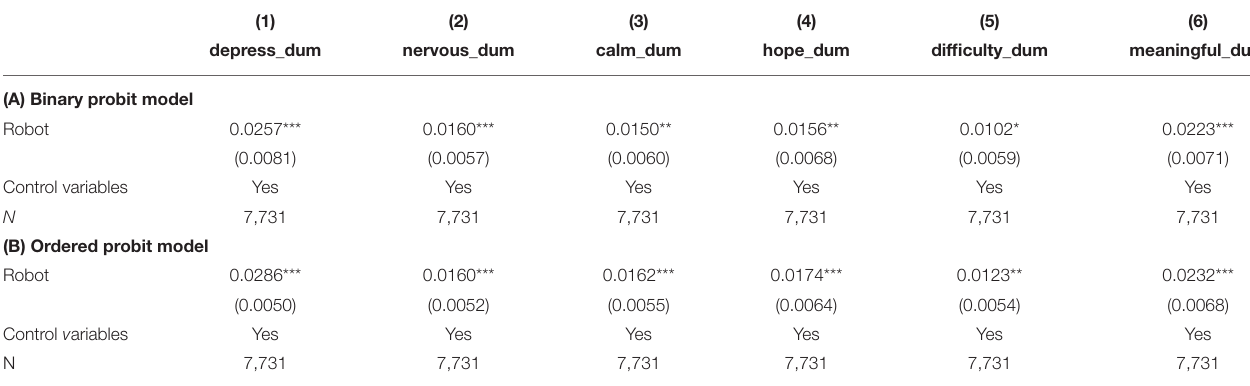
TABLE 5 | Robustness tests: replacing the dependent variable and replacing the regression